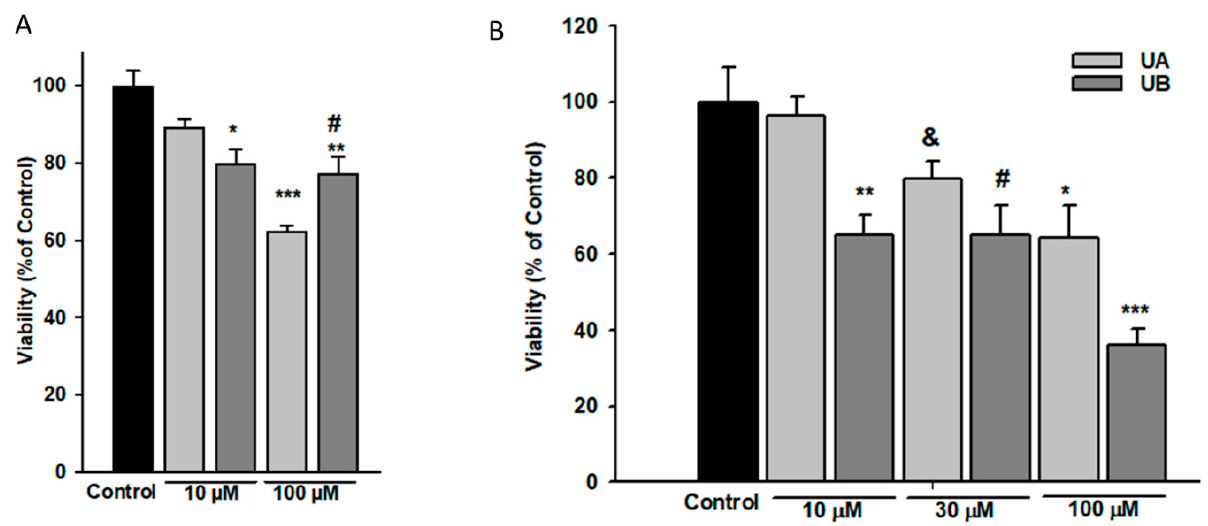
Figure 3. Podocyte viability was impaired by high concentrations of urolithins. Podocytes cultured in normal glucose (5.5 mM, NG) were incubated for 24 h ( A ) or 48 h ( B ) with varying concentrations of urolithins and analyzed by MTT test. Results show mean ± SEM. Control cells were incubated with vehicle (DMSO) alone. ANOVA test was used to calculate p values. For 24-h incubation ( A ) * p < 0.05 vs. Control, ** p < 0.01 vs. Control, *** p < 0.001 vs. Control and 10 µM UA, # p < 0.05 vs. 100 µM UA. For 48-h incubation ( B ) * p < 0.05 100 µM UA vs. 100 µM UB, vs. 10 µM UA, and vs. Control, # p < 0.05 vs. Control, & p < 0.05 vs. 10 µM UA, ** p < 0.005 vs. 10 µM UA and vs. Control, *** p < 0.001 vs. Control. Each MTT test was performed in quadruplicate ( n = 4).